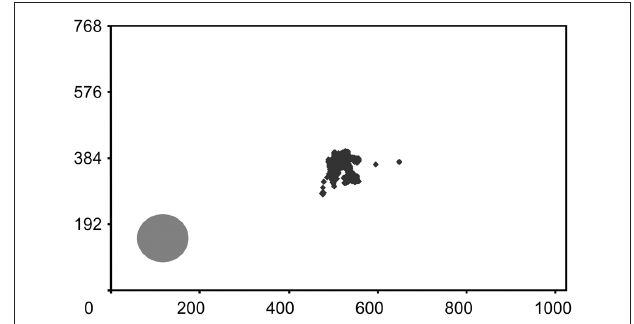
Figure 6 | Fixation control. WF’s fixations during a standard block of 60 trials in the detection task are plotted onto an image of the monitor screen where the high-contrast disk in the blind field is also depicted. The brief fixations to the lower left occurred during the first trial and describe a curve toward the central letters. All segments corresponding to the presentations of the letter stream are given; response periods are eliminated for clarity. Numbers represent pixels. WF scored 85% correct ( χ 2 = 31.1, P < 0.001) and reported no sensation related to